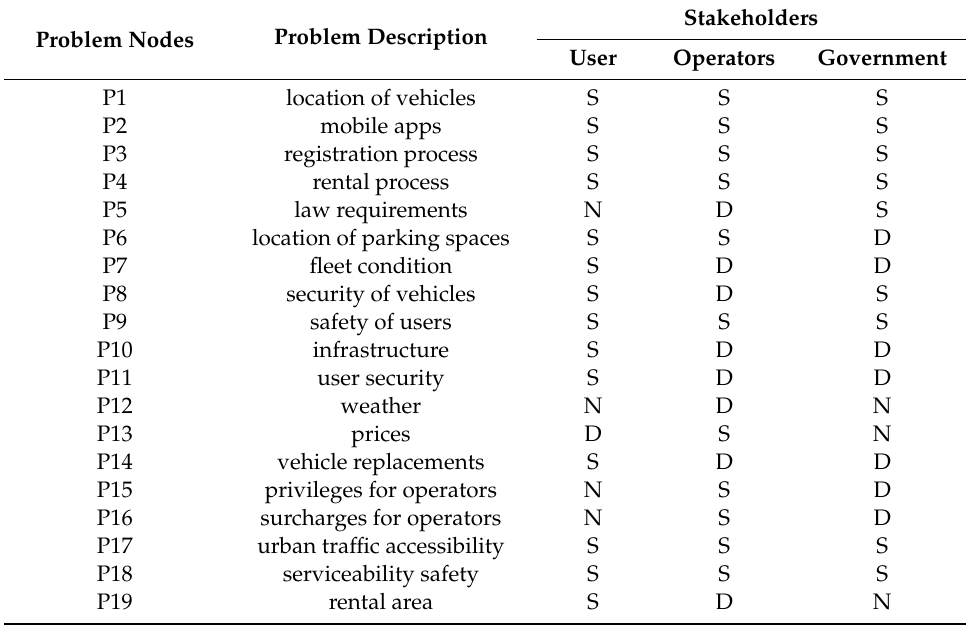
Table 10. Set of variables and their characteristics depending on the group of stakeholders. Problem